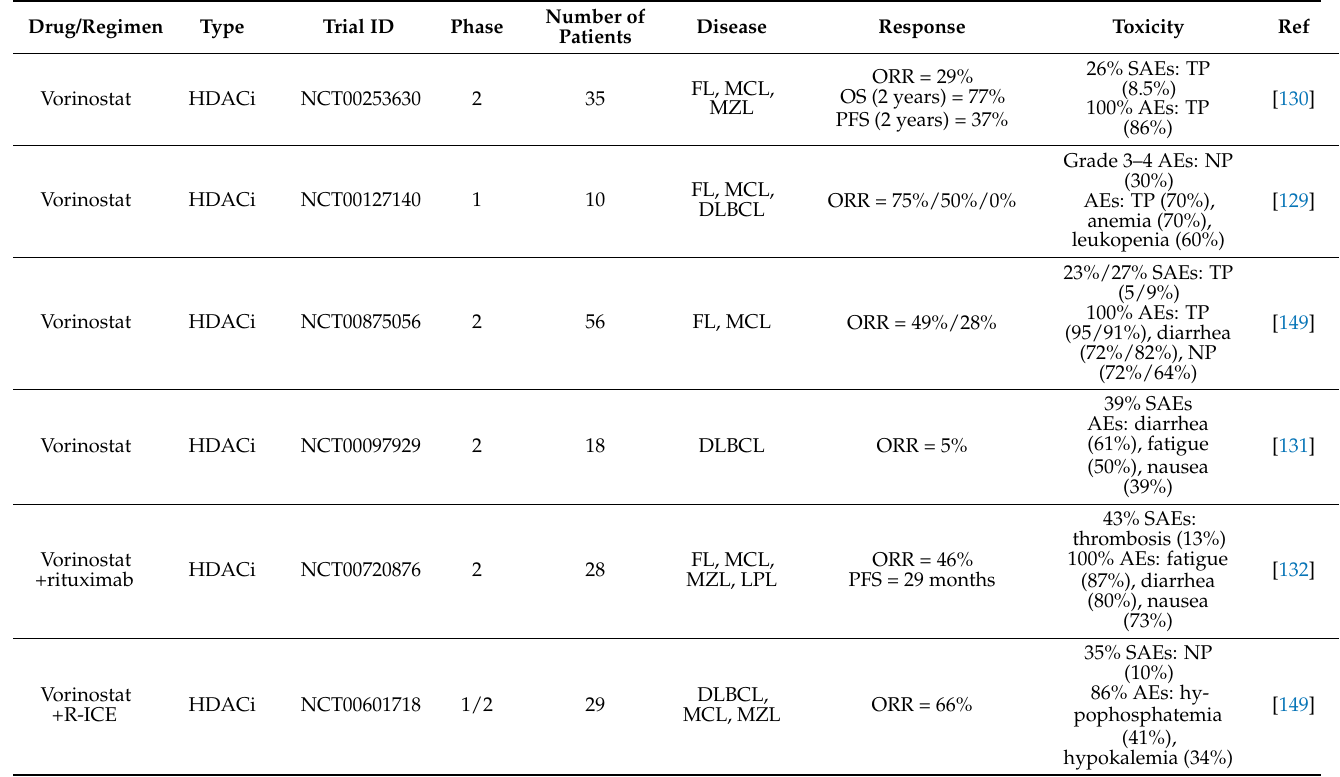
Table 2. Current clinical trials evaluating epi-drugs as single agents and/or in combination regimens in B-NHL